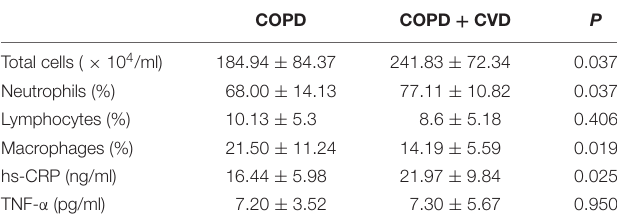
TABLE 5 | The differentiated cell proportion in sputum and inflammatory cytokines in serum between two